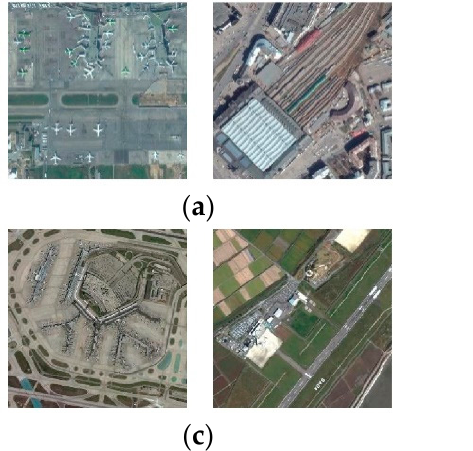
Figure 2. Semantic hierarchy model of three layers structure.